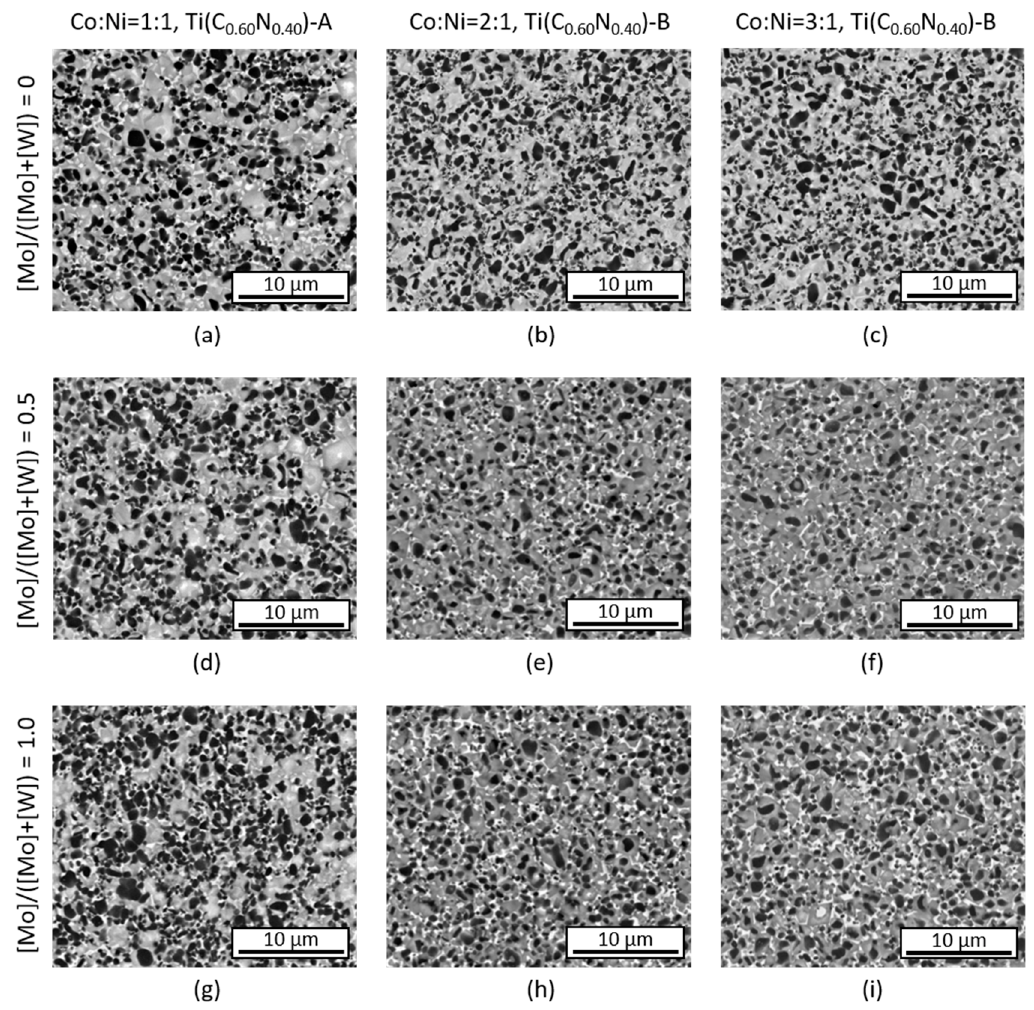
Figure 6. Microstructures of cermets with different Co:Ni ratio (columns), different Ti(C 0.6 N 0.4 ) batches (left column, ( a ), ( d ), ( g ): batch Ti(C 0.6 N 0.4 )-A, middle and right column, ( b ), ( c ), ( e ), ( f ), ( h ), ( i ),: batch Ti(C 0.6 N 0.4 )-B, and different [Mo]/([Mo] + [W]) ratio. The binder composition and [Mo]/([Mo] + [W])